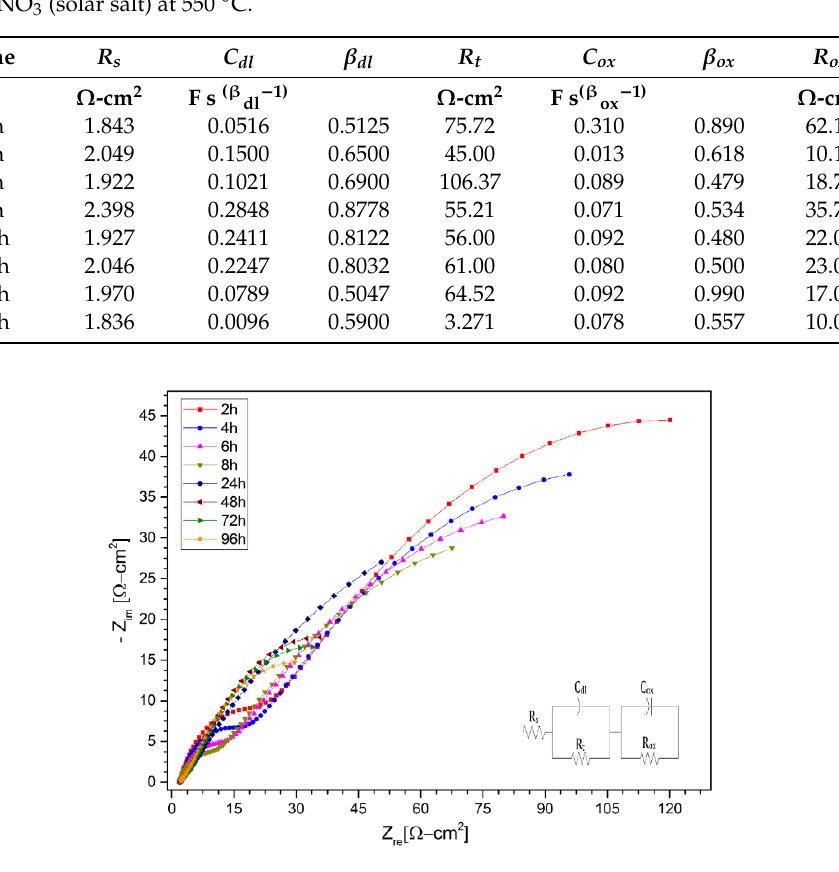
Figure 9. Nysquist diagram of Nickel alloy HR224 layer in (KNa)NO 3 (solar salt) at 2 h, 4 h, 6 h, 8 h, 24 h, 48 h, 72 h and 96 h at 550 °C. Table 5. Fitting results of the impedance spectra of Nickel alloy HR224 during corrosion in the presence of (KNa)NO 3 (solar salt) at 550 °C.